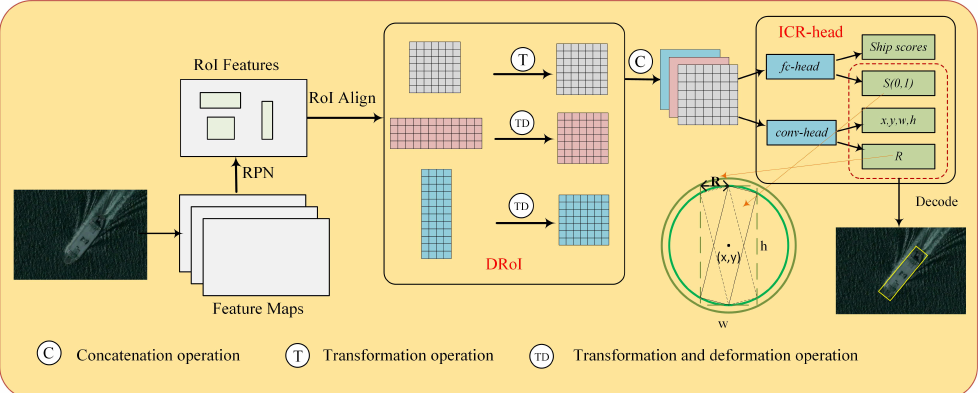
Figure 2. Overview of the our proposed OSCD-Net. Feature extraction and RPN are located on the left. The DRoI module is an intermediate grid rectangle used for enhancement to form the final detection feature. ICR-head on the right is used to detect the horizontal rectangle and a circle, which is decoded into a rotating rectangular